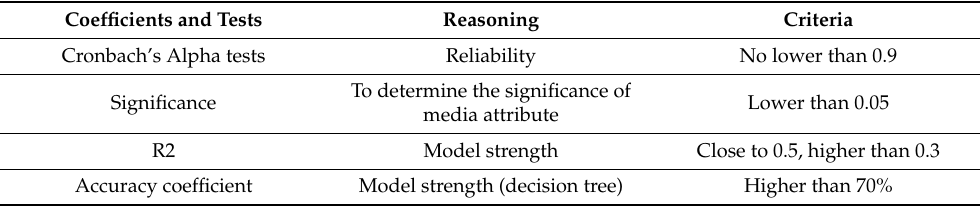
Table 4. Summary of statistical tests to ensure model quality and